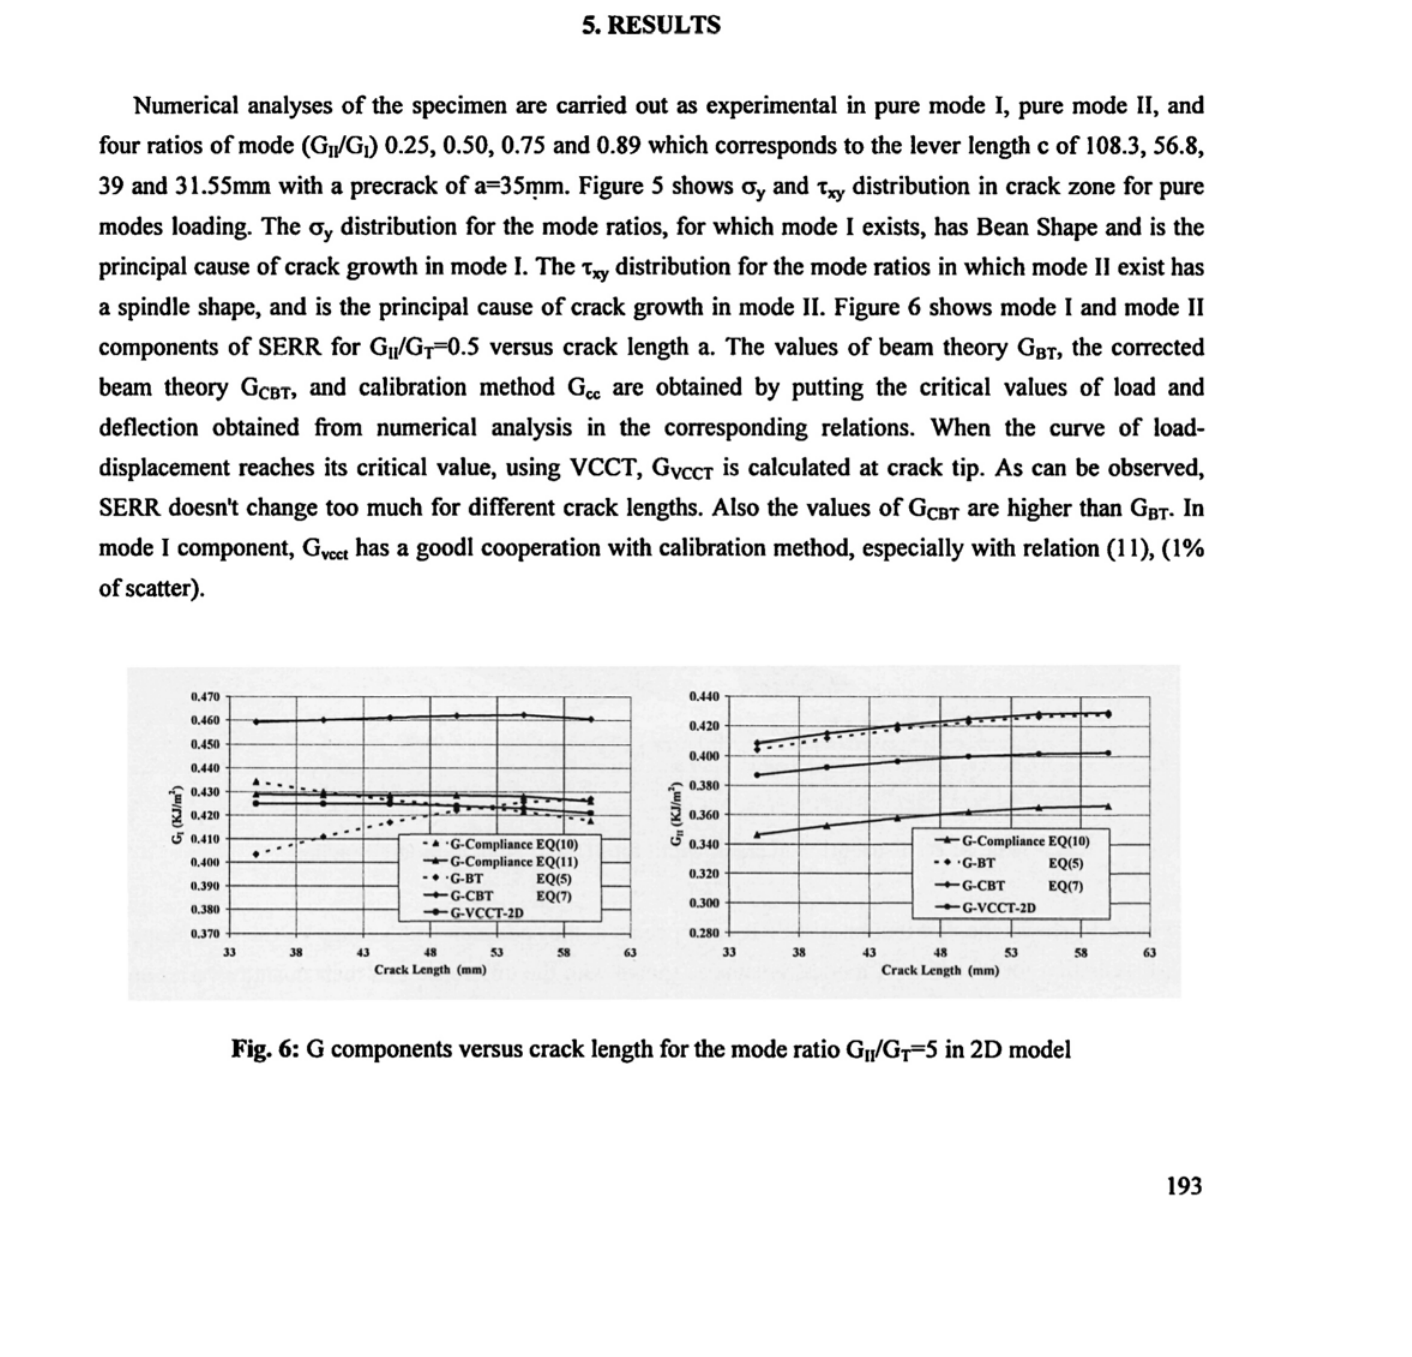
Fig. 6: G components versus crack length for the mode ratio G[i/G-r=5 in 2D model